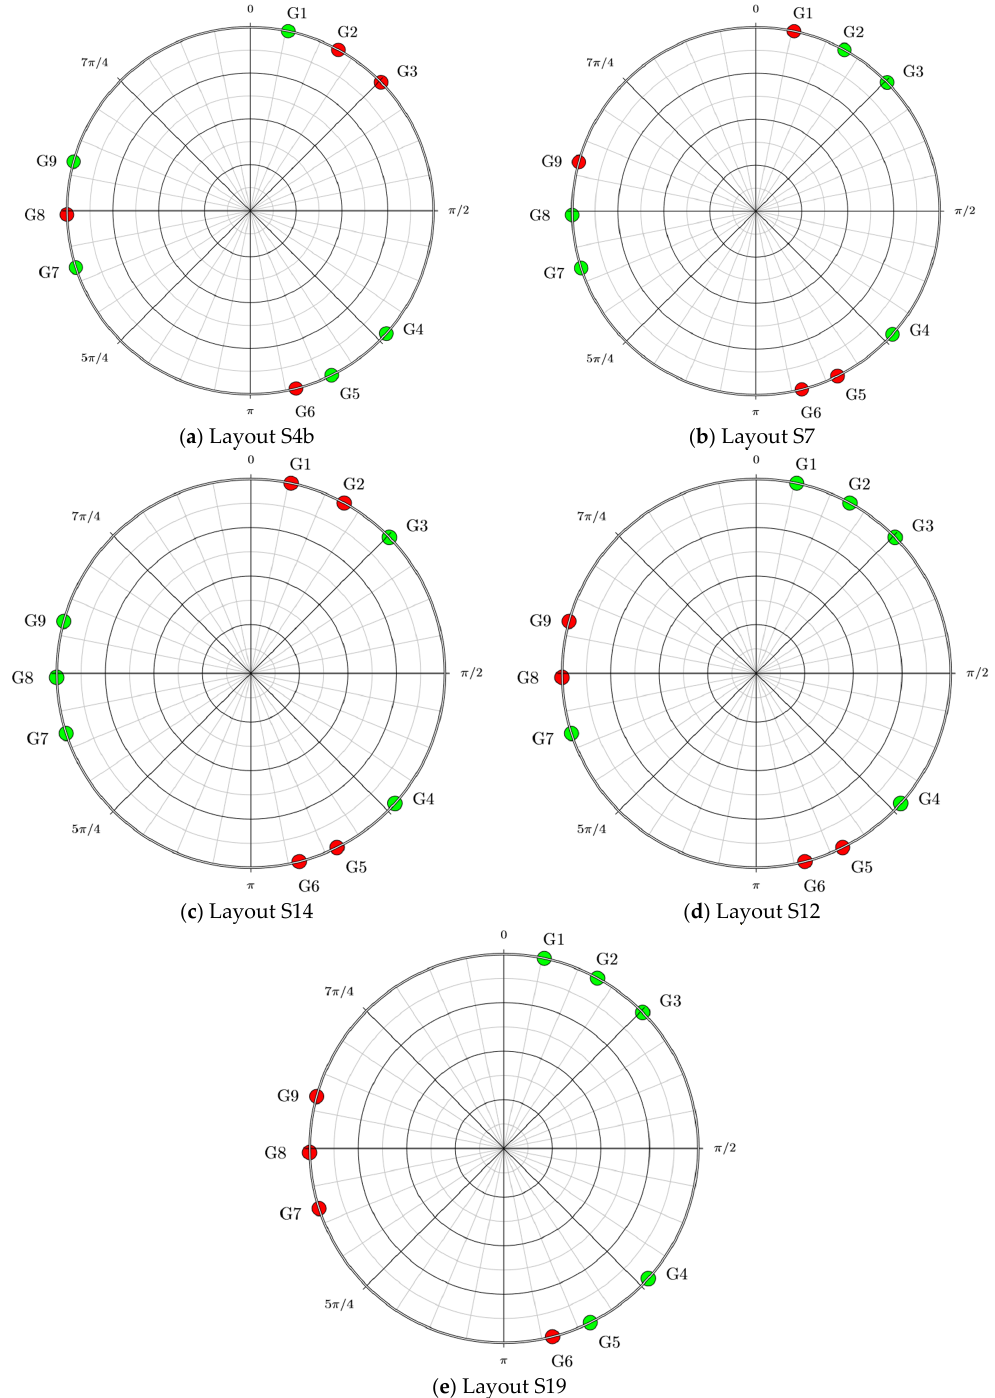
Figure 7. Second set of analyzed layouts. Red points identify the position of control sensors while green points those of reference sensors.